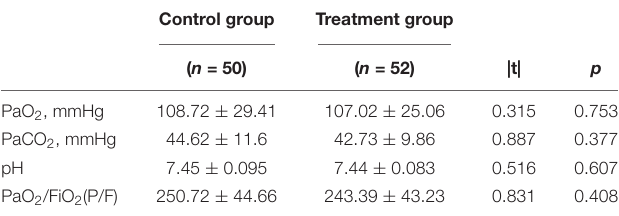
TABLE 2 | Blood gas analysis of patients at